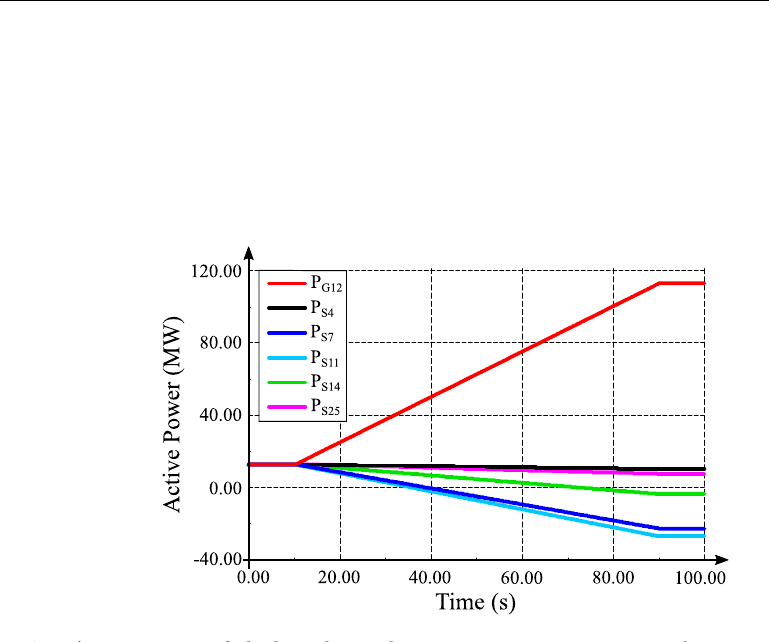
Fig. 14. – Active power of slack nodes and increasing generation at node 12. These results are further supported by fig. 13 (left), which shows the maximum power increases of the consumer and storage power plants, depicted as bars. Consumption is shown as a negative value, and generation as positive values. Due to the resistance in the transmission lines, there will be some losses during the power flow and the total additional power supplied will be slightly greater than the additional demand of 100